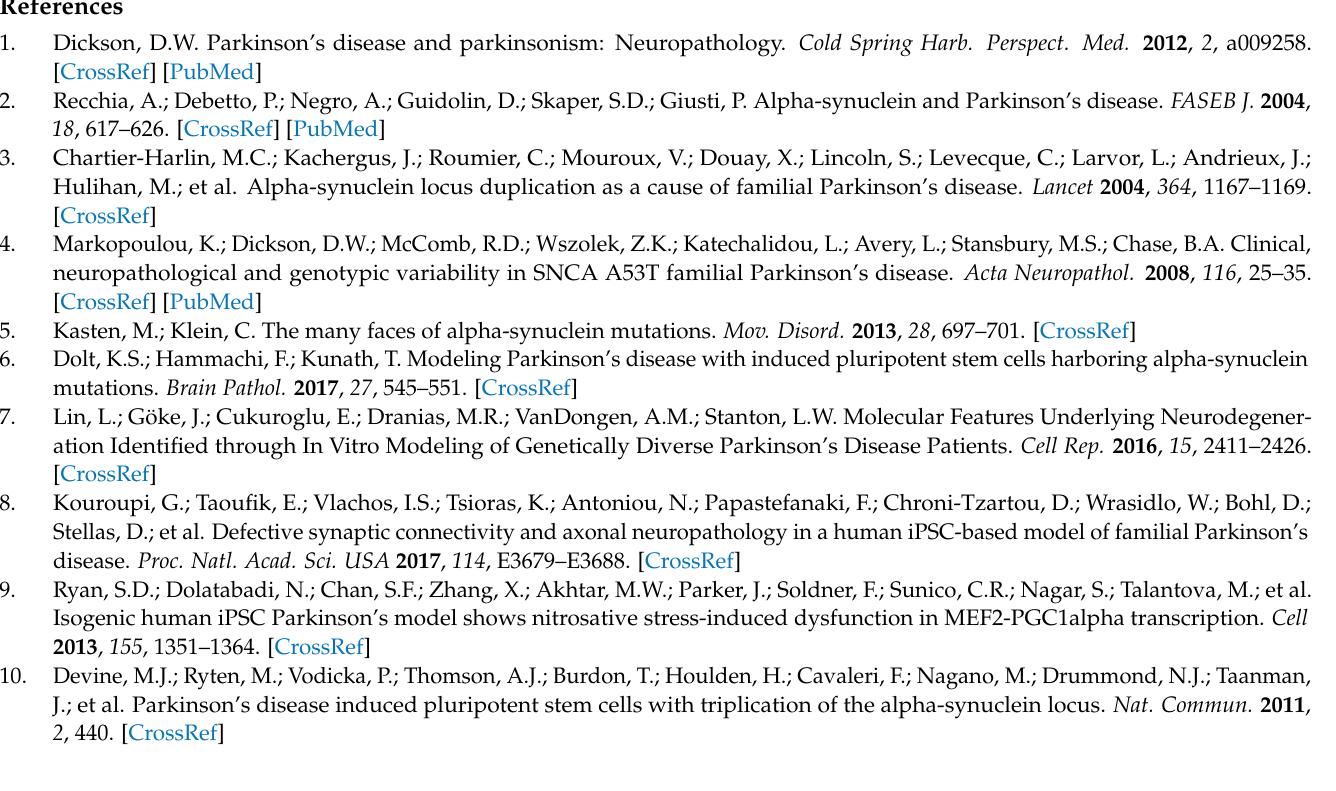
and development genes differentially expressed in PD NPCs. Table S6. Ion Channels and transporters genes differentially expressed in PD NPCs. Table S7. Cytoskeleton genes differentially expressed in PD NPCs. Table S8. Cell adhesion and ECM genes differentially expressed in PD NPCs. Table S9. Synapse genes differentially expressed in PD NPCs. Table S10. Disease-associated genes differentially expressed in PD NPCs. Table S11. DEGs mean expression in iPSC-derived NPC and neurons. Table S12. Metabolism genes expression in PD neurons. Table S13. Differentiation and development genes’ expression in PD neurons. Table S14. Ion channel and transporter genes’ expression in PD neurons. Table S15. Cell adhesion and ECM genes’ expression in PD neurons. Table S16. Synapse-associated genes expression in PD neurons. Table S17. Cytoskeleton gene expression in PD neurons